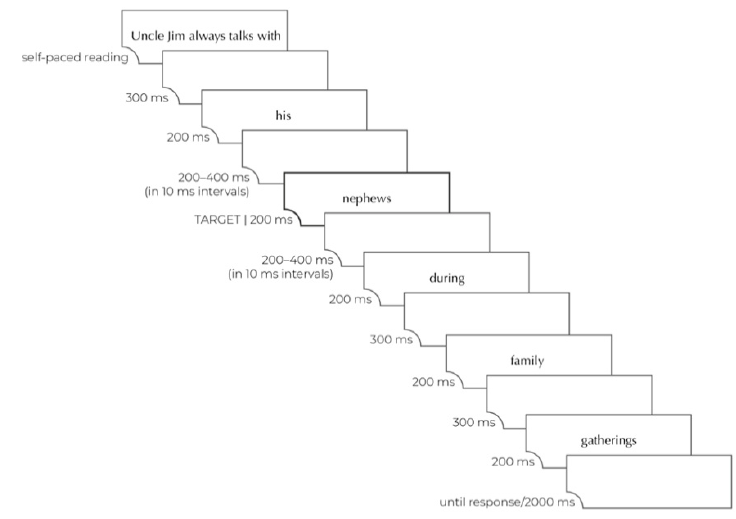
Figure 1. Time sequence of stimulus presentation.